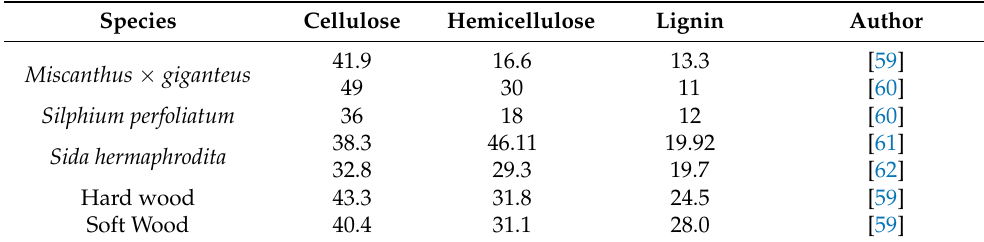
Figure 12. Map of term words with reference to citations. Table 4. Chemical composition of